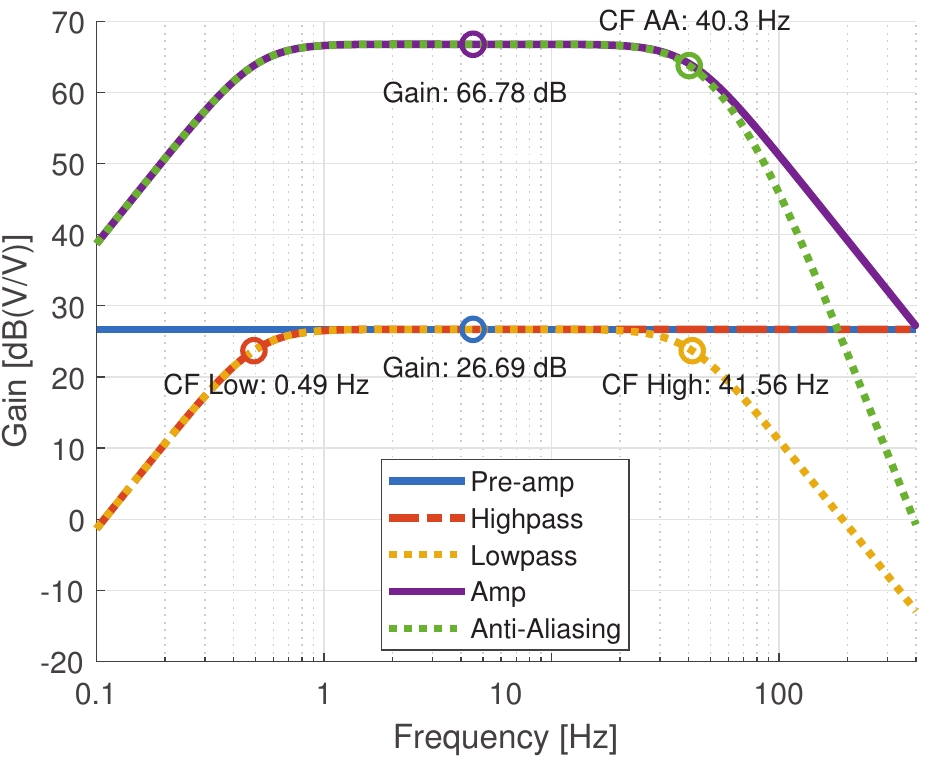
Figure 9. Magnitude response of all stages of circuit 1. “CF” stands for cut-off frequency and “AA” stands for anti-aliasing.